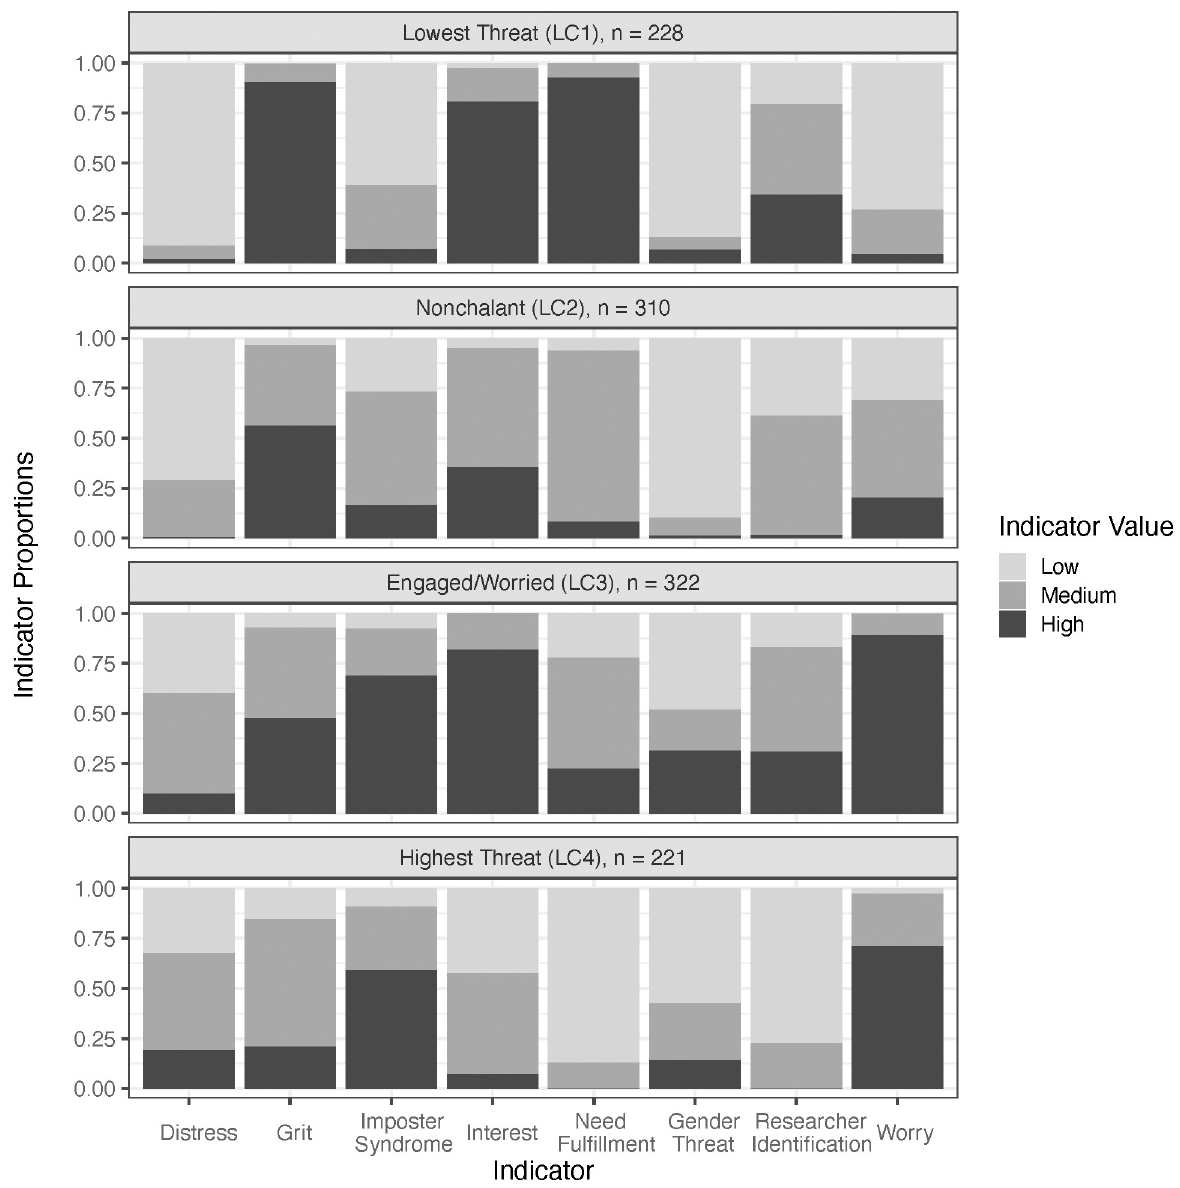
Fig 2. Distribution of indicators by class. LC = Latent Class. “Worry” refers to Academic and Social Concerns.